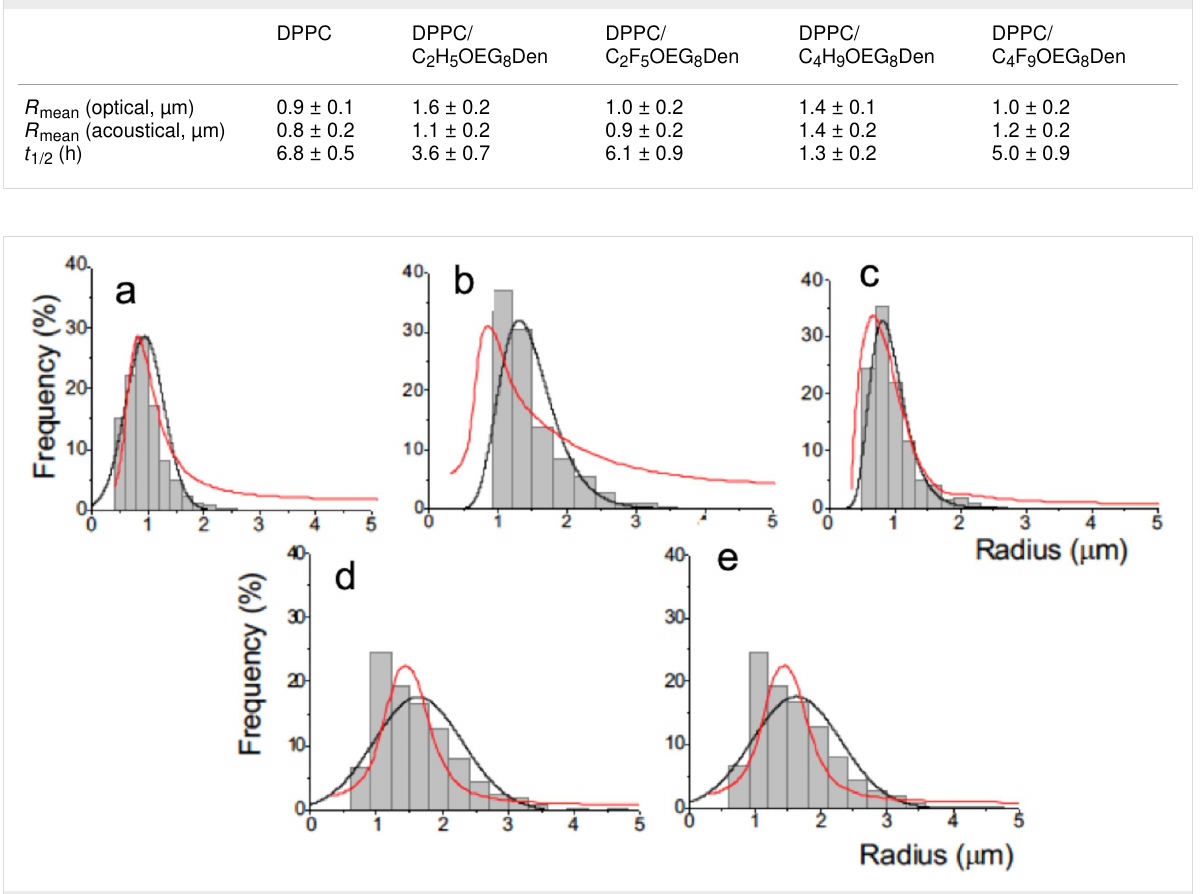
Table 2: Physical characteristics of the DPPC microbubbles with dendronized IONPs, the mean bubble radius derived by optical microscopy ( R mean (optical, µm)), the bubble radius obtained by the acoustical method (Raman (acoustical, µm)) and the determined half-life of the bubbles ( t 1/2 (h)).